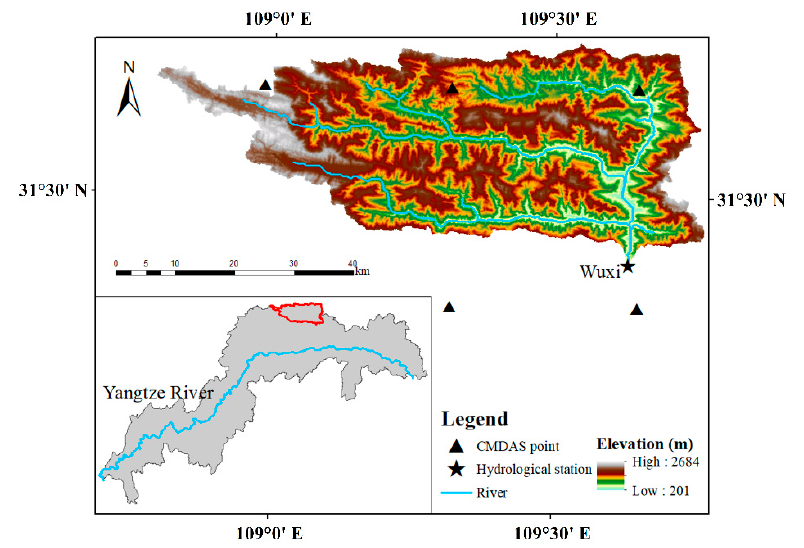
Figure 1. Location of the hydrological station and CMDAS points on the Daning River in the Three Gorges Reservoir area.